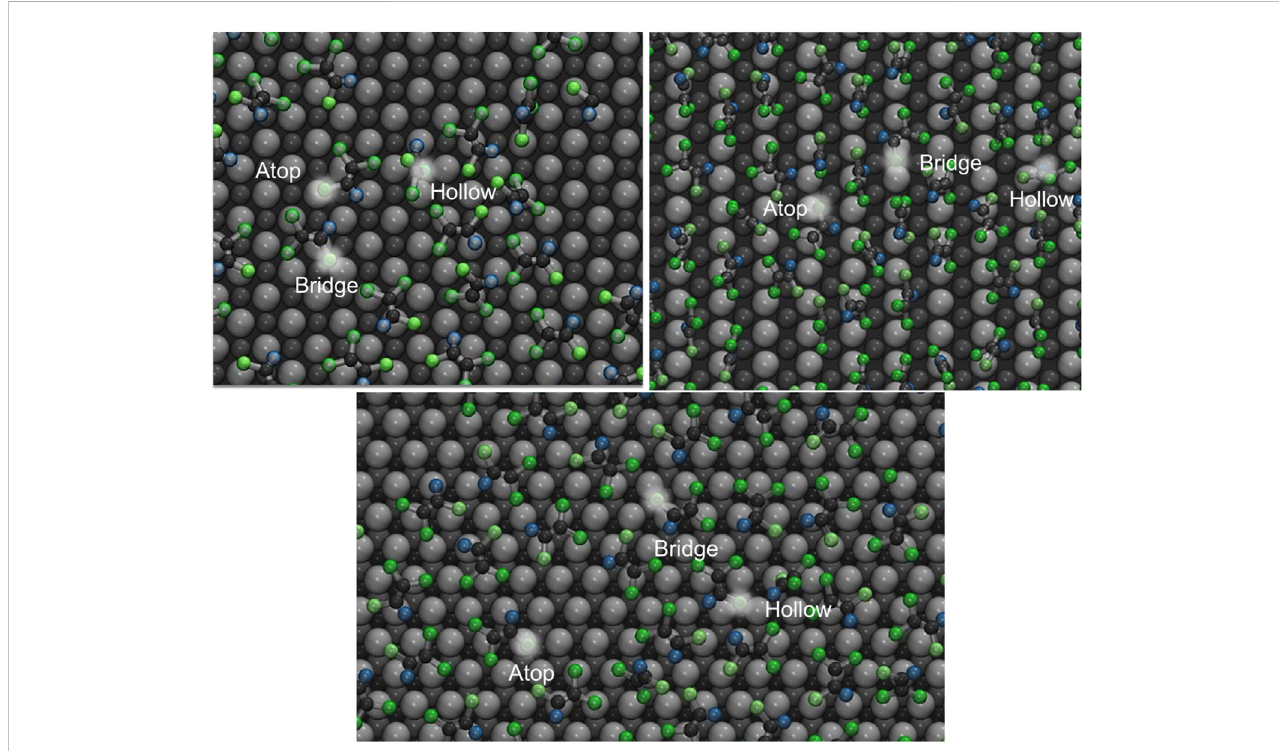
FIGURE 9 Scheme of TCE adsorption on the different adsorption sites on the Pd {100} facet (top left), {110} (top right), {111} (bottom) at 230 K. The bright spots indicate the lowest z-coordinates used to assign adsorption site. Pd substrate coloring is based on the distance from the interface, namely light grey ( fi rst Pd layer), dark grey (second Pd layer), black (third Pd layer only for {111}). Hydrogen, chloride, and carbon atoms are represented by blue, green and matte black respectively.